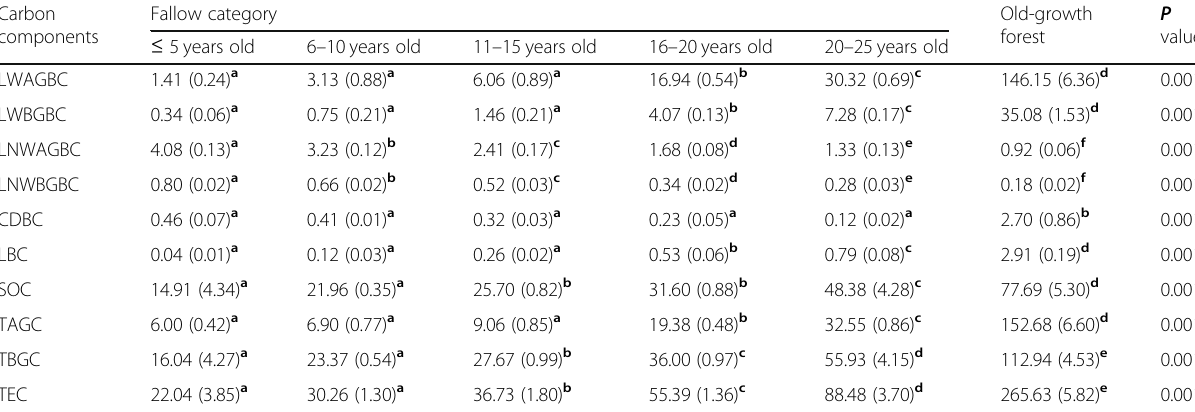
Table 3 Within and between variations of carbon pools (Mg ha − 1 ) across the differently aged jhum. The values in the parentheses are standard error of mean. The values between rows with shared superscripts are not significantly different ( P < 0.01) based on pair-wise comparison Carbon components